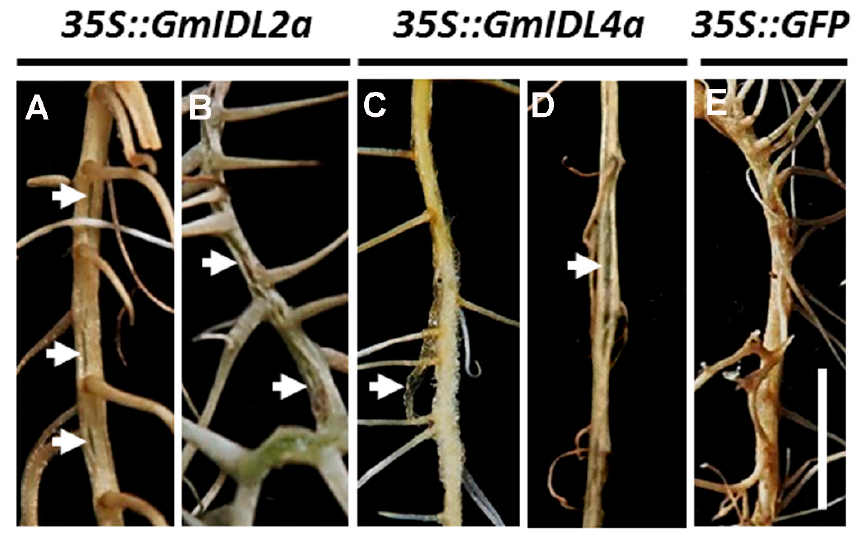
Figure 4. Aberrant morphologies of the 35S::GmIDL2a and 35S::GmIDL4a hairy roots. ( A , B ) Morphologies of 35S::GmIDL2a hairy roots; ( C , D ) morphologies of 35S::GmIDL4a hairy roots; and ( E ) normal root morphology of the 35S::GFP control. Arrows indicate aberrant rifts. Scale bar = 1 cm.